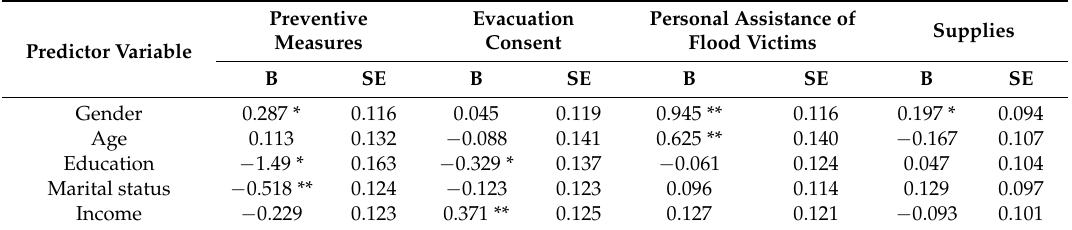
Table 4. Multivariate binary logistic regression analyses used to assess the explanatory power of four chosen predicting variables.